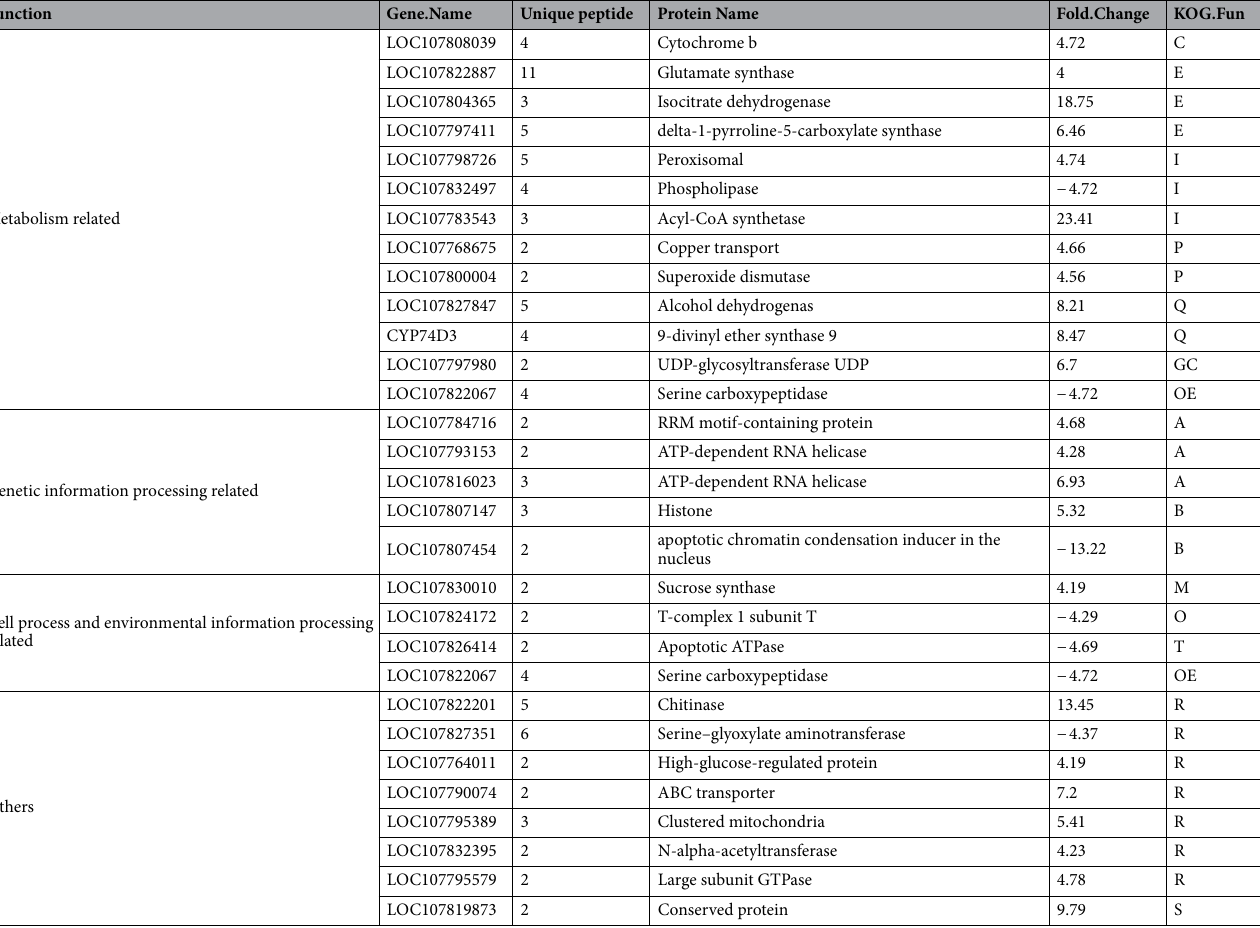
Table 4. Identification of differentially expressed proteins in high potassium treatment. Fold changes are positive numbers indicating up regulated proteins, negative numbers indicate down-regulated